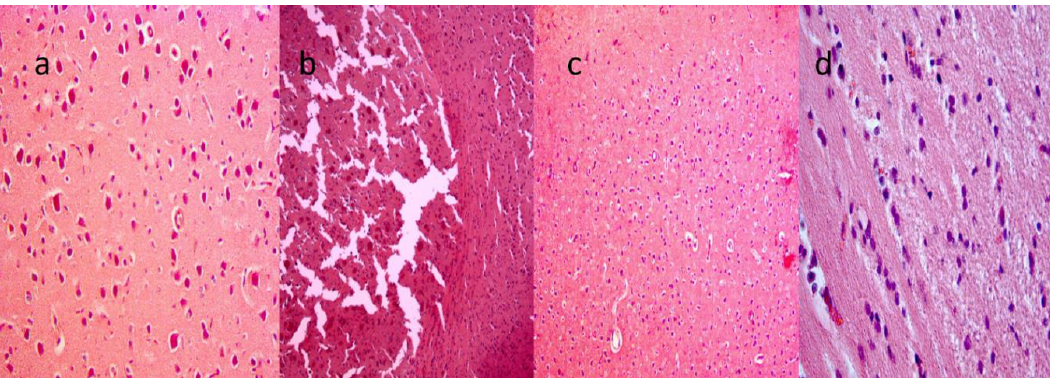
Figure 1. Cortex sections of normal and treated groups at a scale bar of 100 µ m. ( a ) Normal histological appearance of brain tissues with neurocytes having well-defined nuclei. ( b ) CCL4-treated brain cortex section with widespread intracellular vacuolization and infiltration of inflammatory cells (aster). Neurocytes have dark eosinophilic cytoplasm, with cells having heterochromatic nuclei. ( c ) Quercetin-treated brain tissue has fewer vacuoles and inflammation. ( d ) Q + CCL4-treated brain section with mild vacuolization and mild infiltration of inflammatory cells ( n =